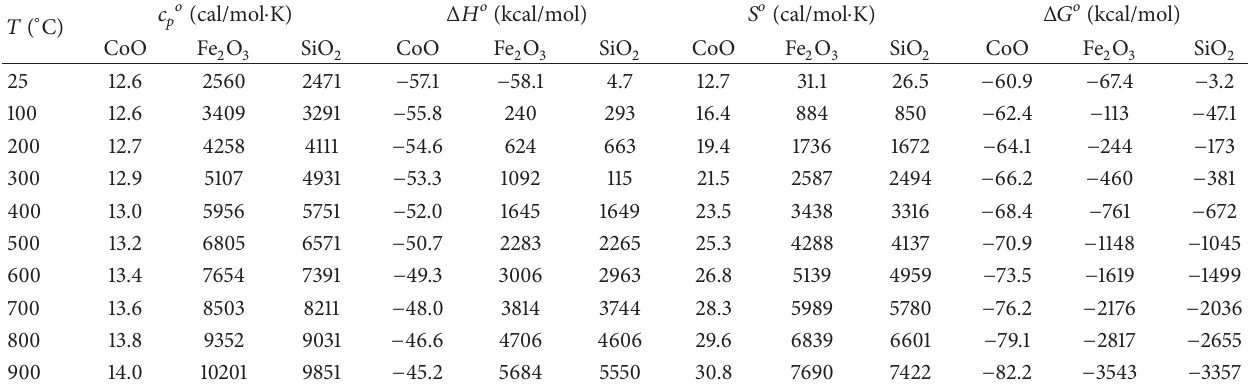
Table 3: Thermodynamic parameters at different temperatures for CoO, SiO 2 , and Fe 2 O 3 .